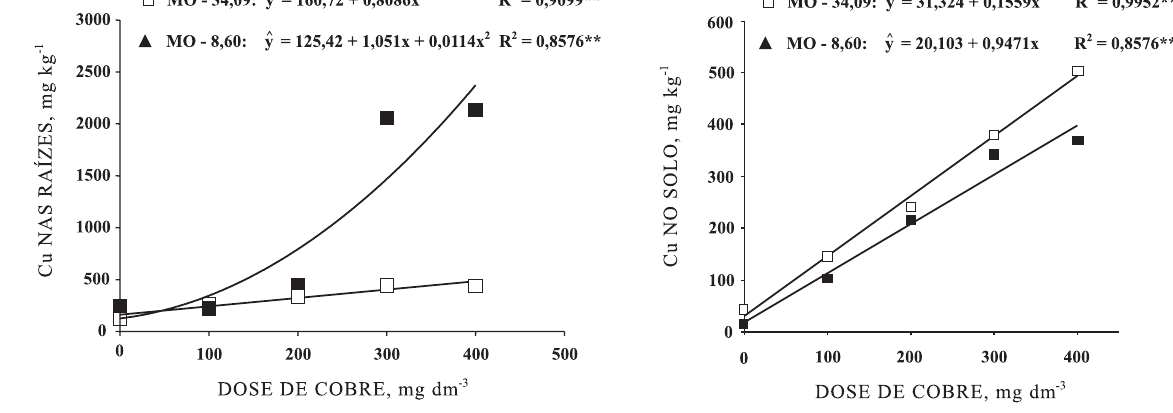
Figura 3. Teores de cobre nas raízes da planta de milho cultivada em amostras de Latossolo Vermelho eutroférrico (duas profundidades de coleta) após receber doses de cobre e dejeto de suíno.